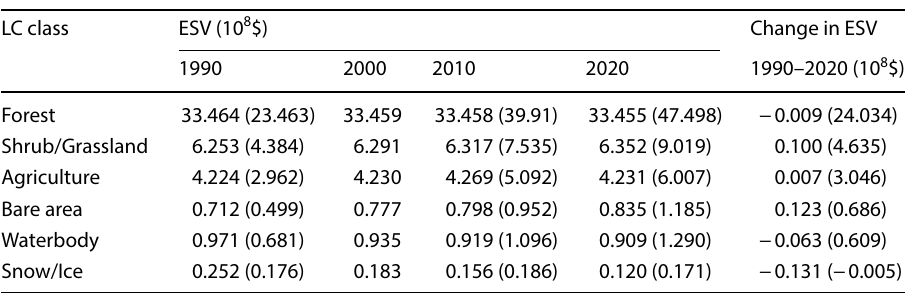
Table 7 ESV of the basin with inflation adjustment in the parentheses